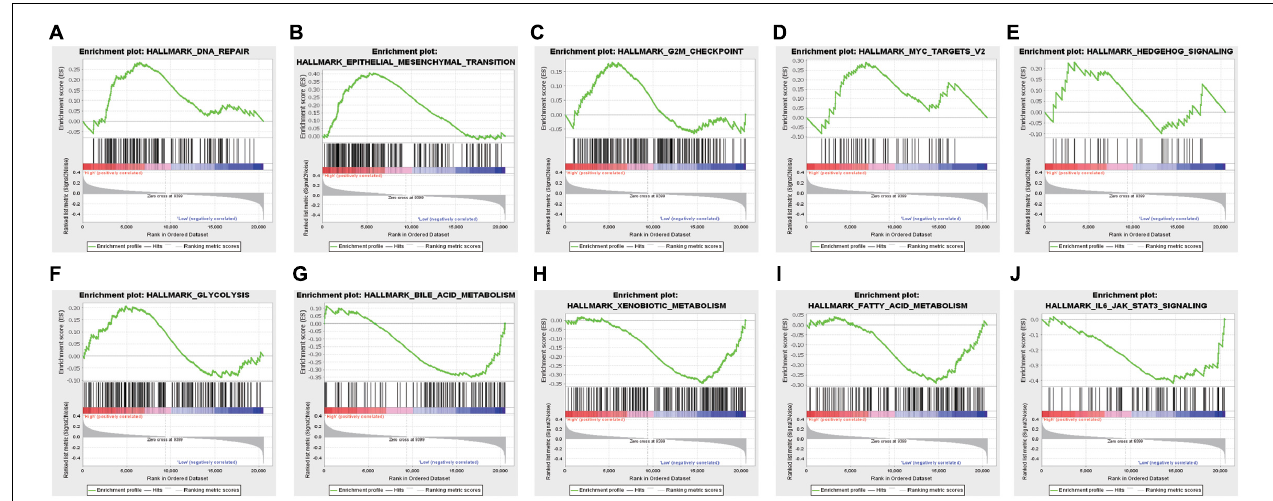
FIGURE 4 | Genes or pathways associated with higher risk are enriched for hallmarks of malignant tumors: (A) DNA repair, (B) epithelial-mesenchymal transition, (C) G2M checkpoint, (D) Myc targets, (E) hedgehog signaling, (F) glycolysis, (G) bile acid metabolism, (H) xenobiotic metabolism, (I) fatty acid metabolism, and (J) JAK-STAT3